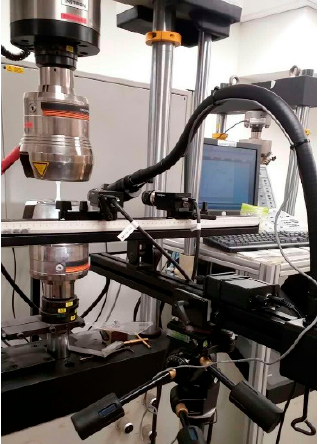
Figure 4. Experimental setup for the tensile tests.